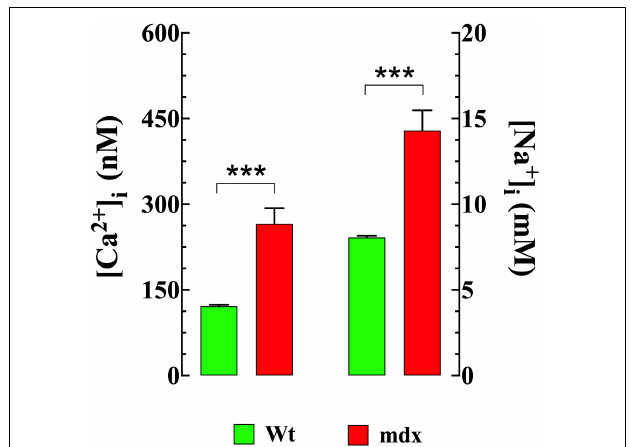
FIGURE 1 | Elevated [Ca 2 + ] i and [Na + ] i in mdx VSMCs. [Ca 2 + ] i or [Na + ] i was measured in quiescent VSMCs isolated from Wt, and mdx mice using double-barreled ion-specific microelectrodes. [Ca 2 + ] i and [Na + ] i were significantly higher in mdx than Wt VSMCs. For [Ca 2 + ] i measurements : n mice = 3/experimental condition, n cell = 41–48/genotype; For [Na + ] i measurements: n mice = 3/experimental condition, n cell = 25–27/genotype. Values are expressed as means ± S.D. Student’s t -test, *** p ≤